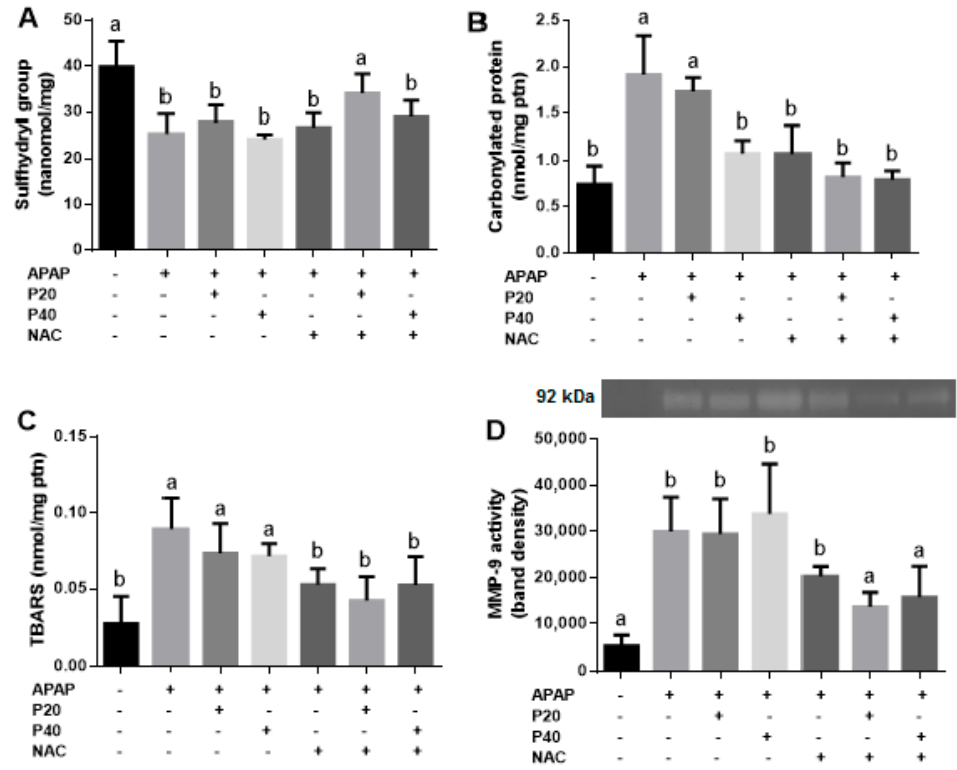
Figure 3. Evaluation of sulfhydryl group concentration ( A ). The levels of carbonylated protein ( B ). The levels of thiobarbituric acid-reactive substances (TBARS) ( C ). The enzymatic activity of matrix metalloproteinase (MMP-9) ( D ) in paracetamol intoxicated C57BL/6 mice. Statistical analysis was performed using one-way analysis of variance and Tukey’s post-test. Different letters (a, b) indicate significant difference between groups ( p < 0.05), whereas the same letters indicate no significant difference between groups ( p > 0.05). (+) Presence or ( − ) absence of paracetamol, piperine 20 mg/kg, piperine 40 mg/kg, N-acetylcysteine.